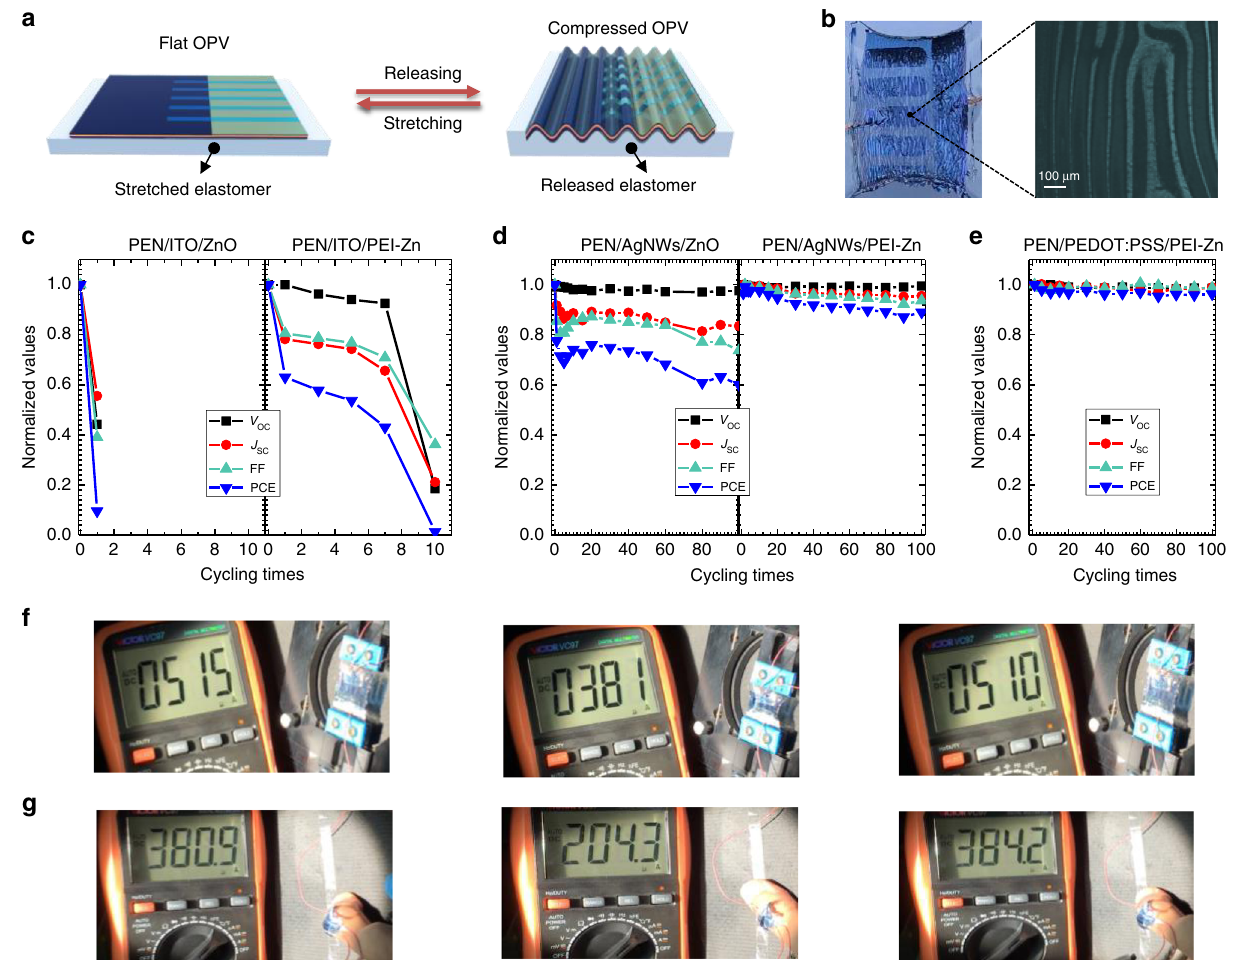
Fig. 3 Extreme mechanical fl exibility. a Illustration of the ultrathin OSCs attached onto the 300% pre-stretched elastomer (VHB) to demonstrate the extreme fl exibility; the cells are at fl at and compressed states by stretching and releasing the elastomer. When the elastomer is stretched to the pre- stretched state, the ultrathin cell becomes fl at. When the elastomer is released, the cell is at the compressed state. b Picture of ultrathin cells on a released elastomer with a 45% compression. The right is an image of an compressed cell under an optical microscope; Evolution of photovoltaic parameters after different compressed- fl at cycles of ultra fl exible of cells with different electrode/ETL: c with PEN/ITO/ZnO and PEN/ITO/PEI-Zn; d with PEN/AgNWs/ ZnO and PEN/AgNWs/PEI-Zn; e with PEN/PEDOT:PSS/PEI-Zn; Pictures captured from the supplementary videos to demonstrate the current recovery during the cycling: f cell on a stretching-releasing apparatus; g cell attached on a fi nger